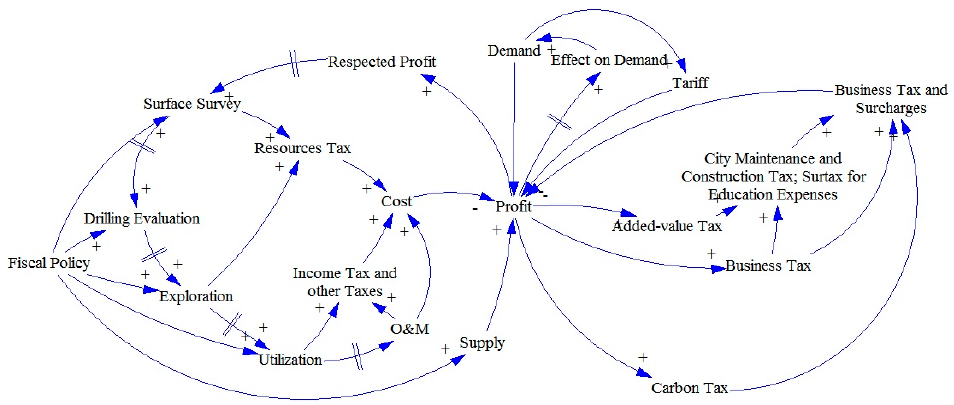
Figure 2. System of fiscal and tax policies affecting geothermal industry.